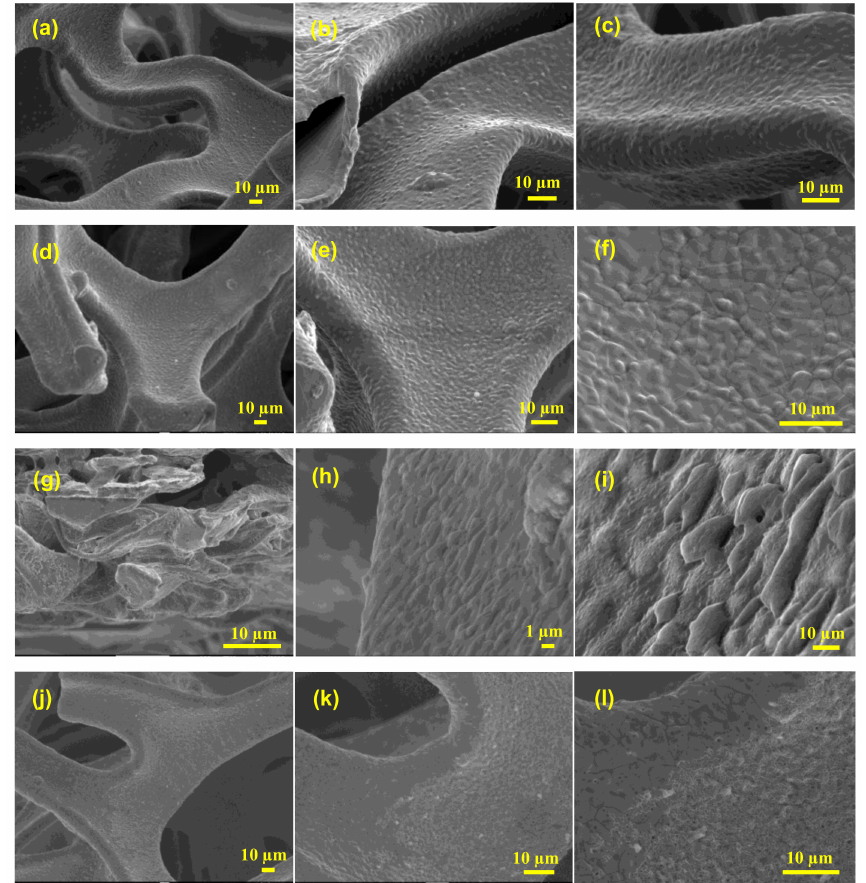
Figure 1. ( a – c ) SEM images of commercial Ni-foam; ( d – f ) SEM images of Ni-foam washed with ethanol; ( g – i ) SEM images of Ni-foam washed with 1M HCl solution; and ( j – l ) SEM images of Ni-foam washed with 3M HCl solution at different